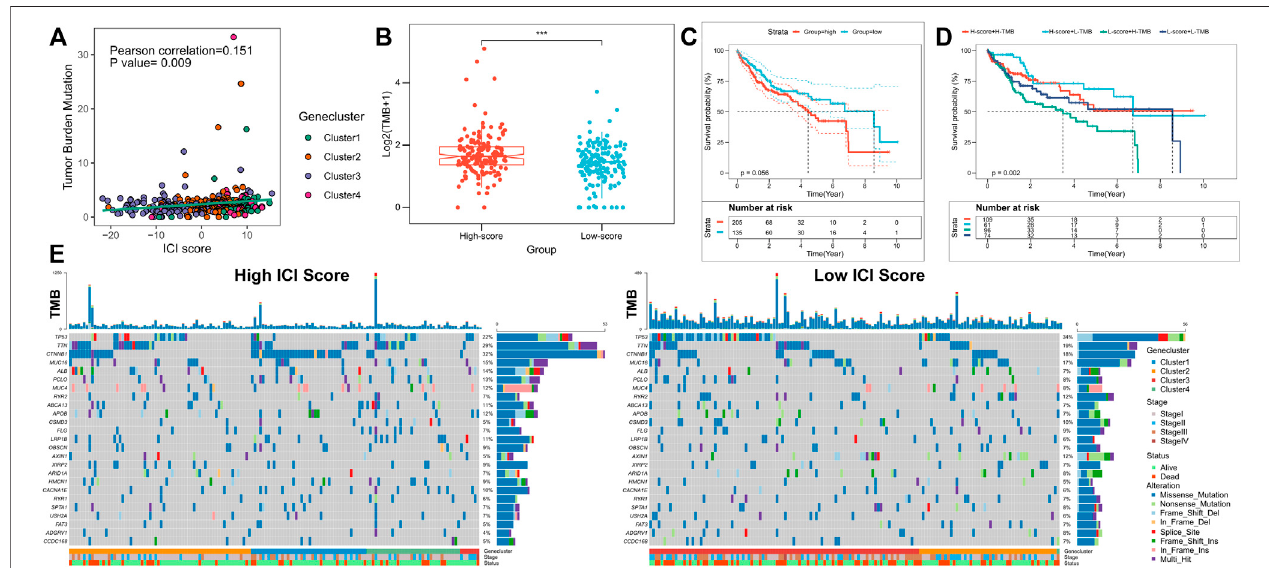
FIGURE 5 | Correlation between ICI scores and somatic cell variation. (A) Difference in TMB between the high and low ICI score subgroups, where p < 0.001 for Wilcoxon test; (B) Scatter plot depicting a positive correlation between ICI scores and the mutational burden in the TCGA cohort, showing the Pearson correlation betweenICIscoresandthemutationalburden; (C) Kaplan-MeiercurvesforthehighandlowTMBscoresubgroupsintheTCGAcohort,where p (cid:1) 0.056forthelog-rank test; (D) Kaplan-MeiercurvesforpatientsintheTCGAcohortstrati fi edbyTMBandICIscores,where p (cid:1) 0.002forthelog-ranktest; (E) “ oncoplot ” showingthehigh and low ICI score subgroups for the top 25 mutant genes, with each column representing one patient.